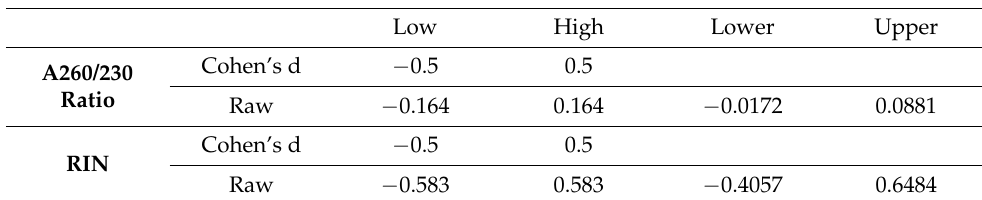
TOST Upper—Upper limit of confidence interval; TOST Lower—lower limit of the confidence